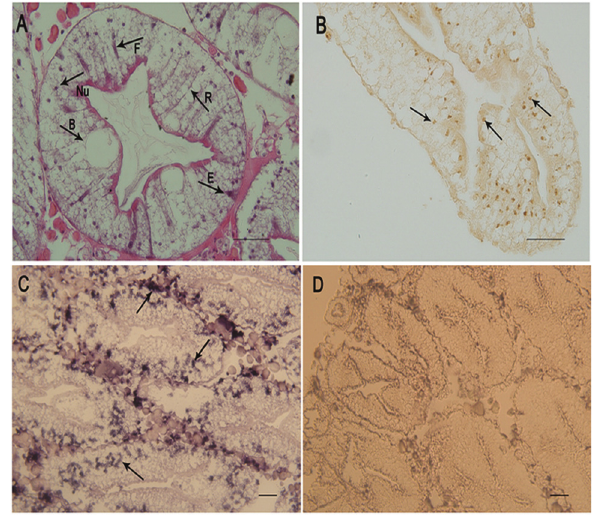
Figure 5 - Location of SpCHY by immunocytochemistry and in situ hy- bridization in hepatopancreas of S. paramamosain . (A) histological obser- vation; R resorptive cells, B blister cells, E embryonic cells, F fibrillar cells, Nu nucleus. (B) immunocytochemistry results; the arrows point to immunocytochemicalpositivesignals.(C) insitu hybridizationresults;ar- rows indicate the specific SpCHY mRNA hybridization signal with the antisense riboprobe. (D) The negative control with the sense riboprobe showed no specific signal. Scale bars: 50 (cid:2) m.